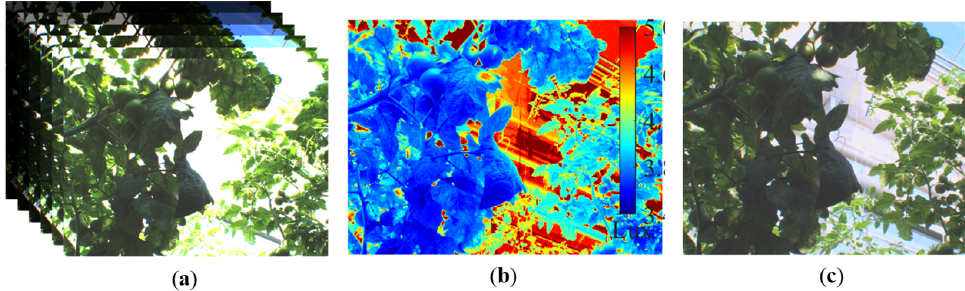
Figure 4. Color correction from multi-exposure images (Photo: Reprinted with permission from Ref. [53]. 2020, Feng Q.). ( a ) Multi-exposure images; ( b ) radiation intensity estimation; and ( c ) image color